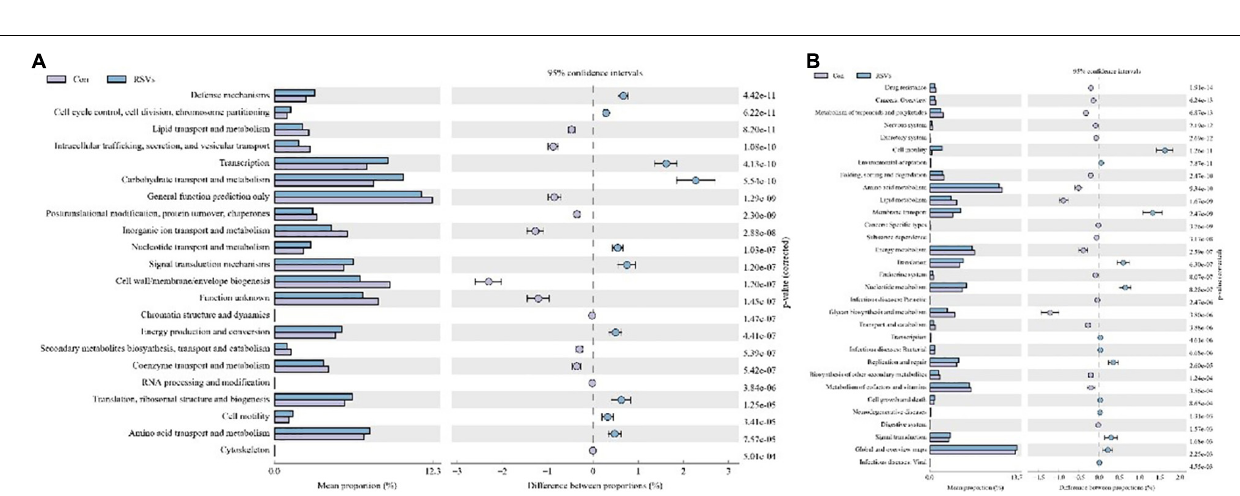
FIGURE 9 | Effect of RSV on predictive functional profiling of microbial communities in the cecum content of weaned mice at the genus level. (A) The KEEG genus level and (B) COG genus level were generated by OTU annotation by PICRUSt software analysis. Con = control group, RSVs = 10 mg/kg RSV, RSV20 = 20 mg/kg RSV and RSV50 = 50 mg/kg RSV